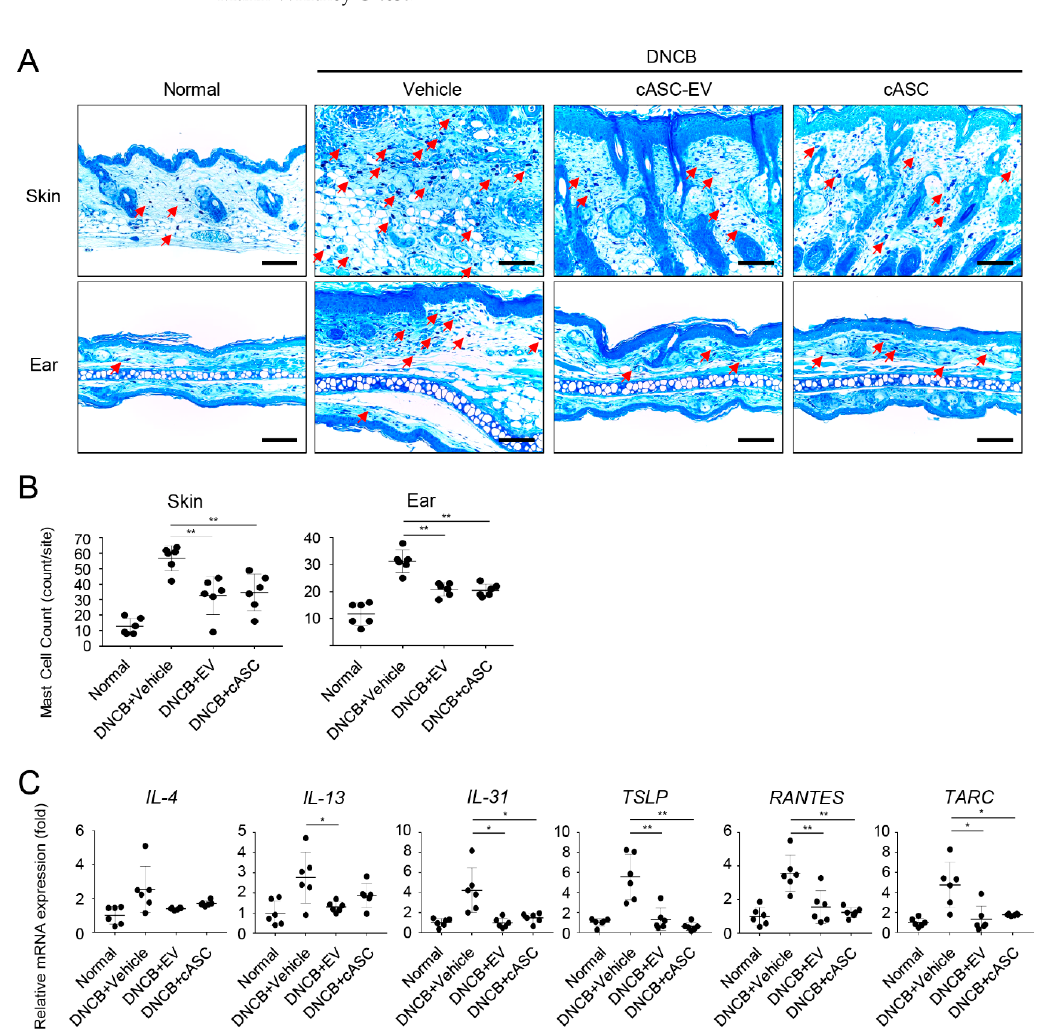
Figure 3. cASC and cASC-EV reduce the level of multiple inflammatory cytokines in atopic dermatitis-like skin lesions of Balb/c mice. ( A ) Tissue sections from the back skin and ears stained with Toluidine blue (TB). Red arrow indicates mast cell infiltrated into skin or ear tissue. Scale bar, 100 μ m. ( B ) The number of mast cells counted from five random section areas ( n = 6/group). ( C ) The expression of IL-4, IL-13, IL31, TSLP, RANTES and TARC genes on skin tissues as determined using real-time PCR ( n = 6/group). The expression of TARC gene represent median [IQR] (min–max) and the others represent mean ± SD. Significant value was * p < 0.05, ** p < 0.01 vs. DNCB + Vehicle. 2.4. cASCs and cASC-EVs Promote Skin Barrier Repair in DNCB-Induced Atopic Dermatitis Mice To evaluate skin barrier function, transepidermal water loss (TEWL) and hydration were measured by using tewameter and corneometer in DNCB-induced AD-like skin lesions. As shown in Figure 4A, multiple DNCB-exposures markedly resulted in the increment of TEWL and decrement of hydration on dorsal skin. However, increased TEWL of AD-like skin lesion markedly decreased in cASCs and cASC-EVs groups on day 28 compared to the vehicle group (Figure 4A and Table 1). Moreover, cASCs and cASC- EVs significantly recovered reduced hydration compared to the vehicle group (Figure 4B